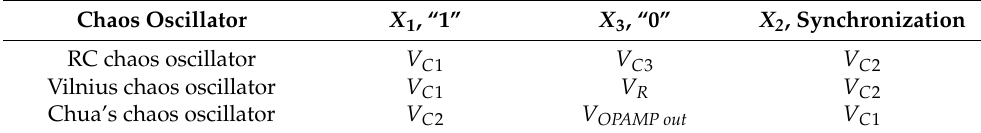
Table 3. State variables of three chaos